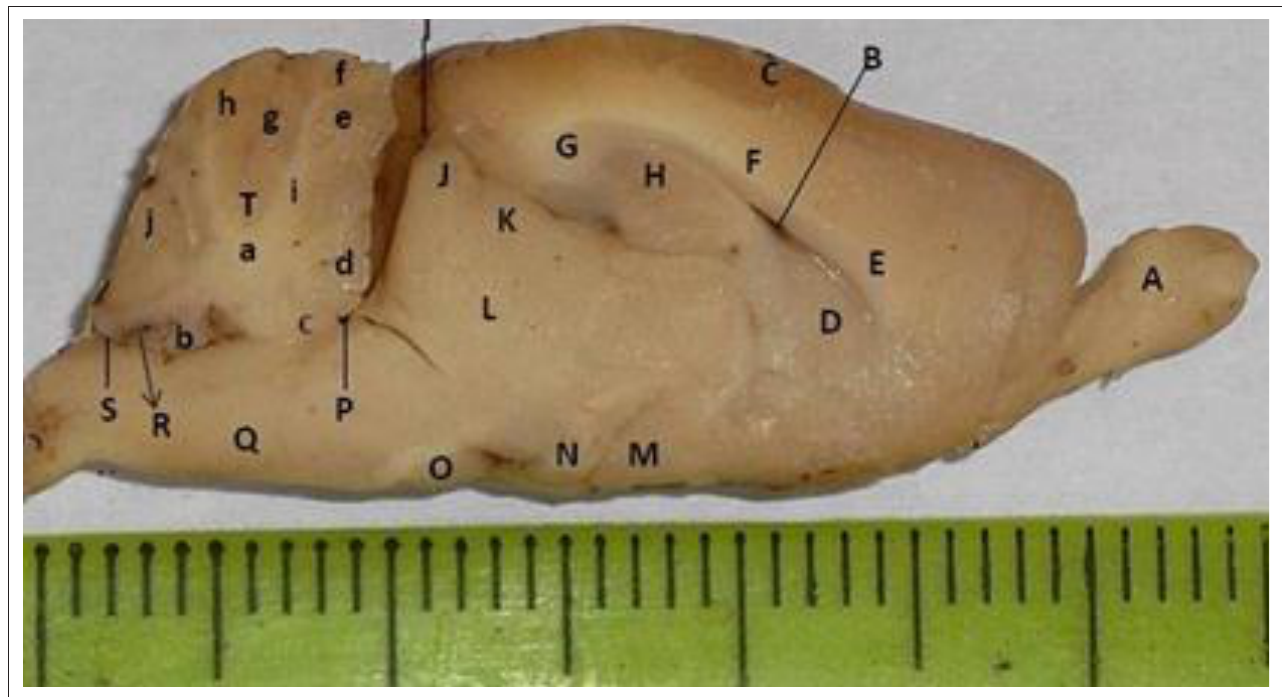
FIGURE 4: Mid-sagittal view of the brain of the African giant pouched